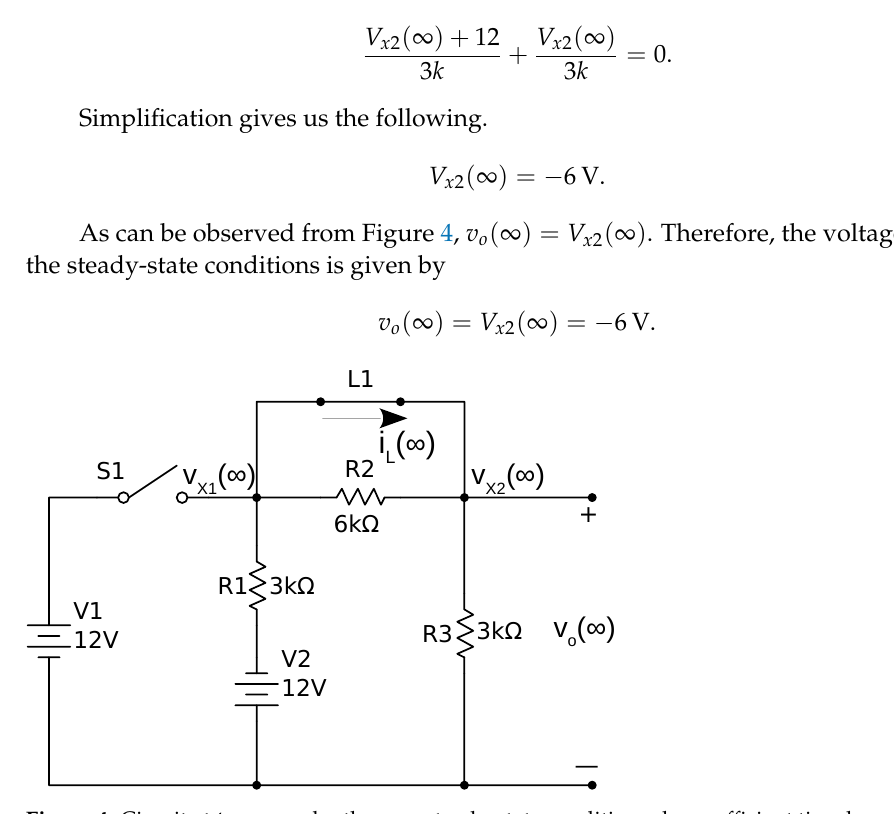
Figure 4. Circuit at t = ∞ under the new steady-state condition when sufficient time has elapsed after switch S1 is opened. The inductor acts as short circuit, and a steady state current flows through